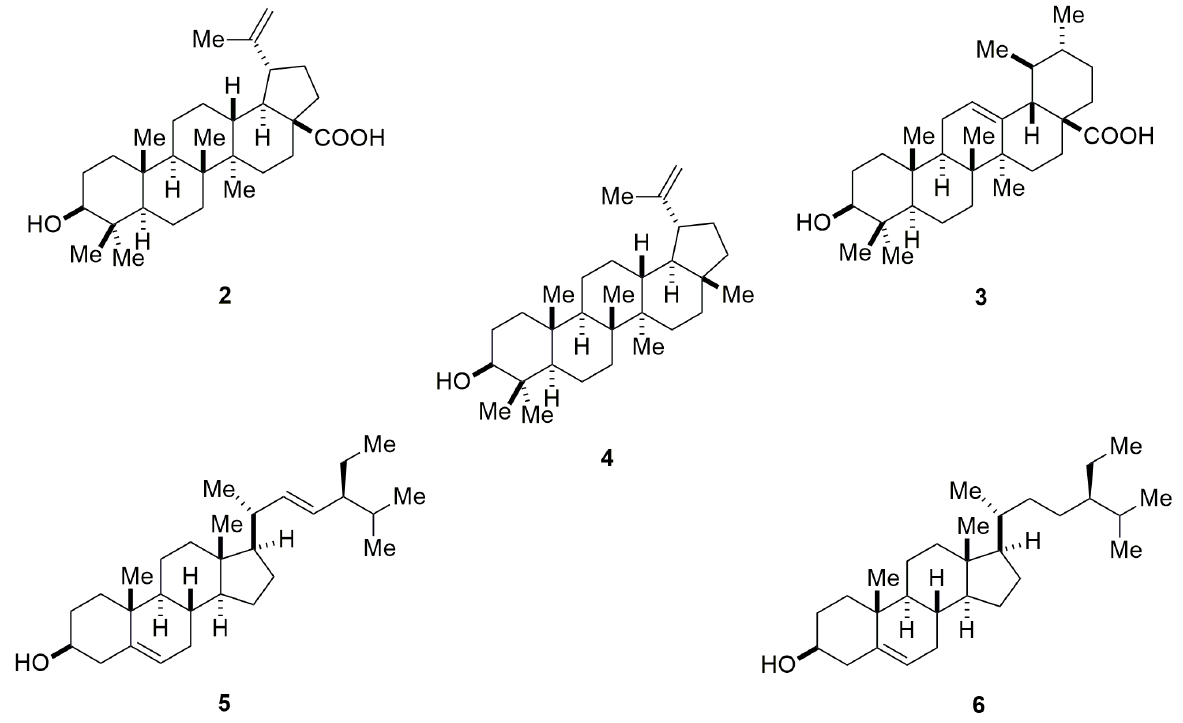
Figure 2 - Structures of betulinic and ursolic acids ( 2 and 3, respectively), lupeol ( 4 ), stigmasterol ( 5 ) and β -sitosterol ( 6